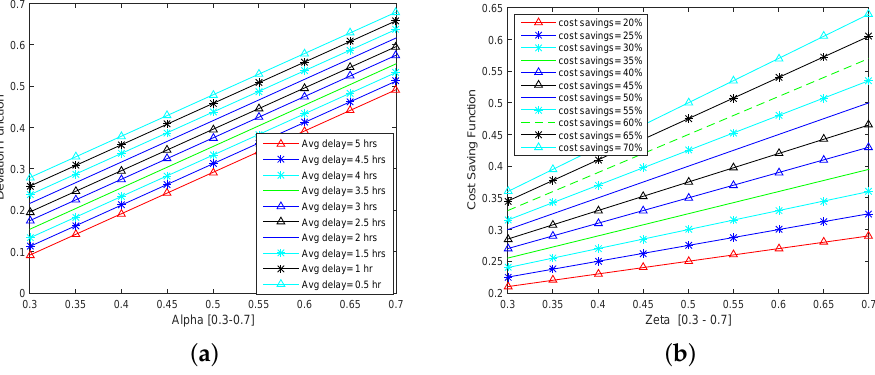
Figure 1. Appliance utility and cost saving functions. ( a ) E appUtil w.r.t avg D ; ( b ) E costSavings w.r.t savings in